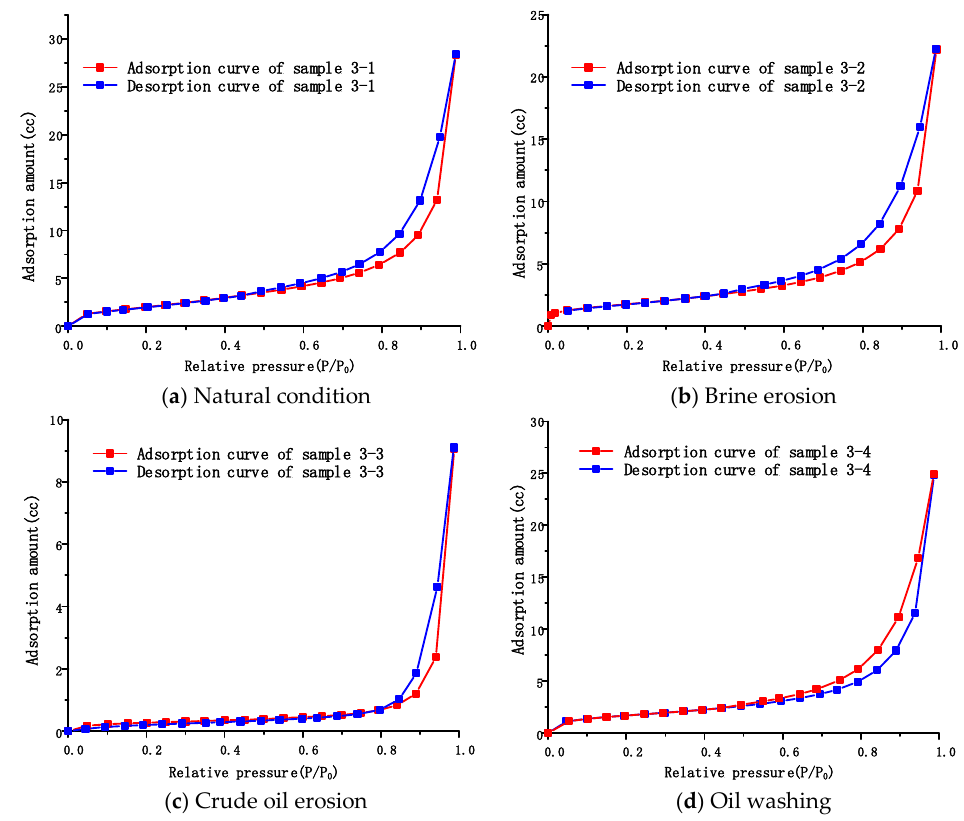
Figure 8. The adsorption isotherms of caprock samples under different sample treatment conditions.